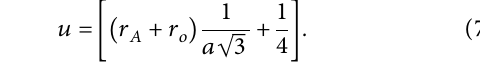
� 0.25 and 0.75) with annealing